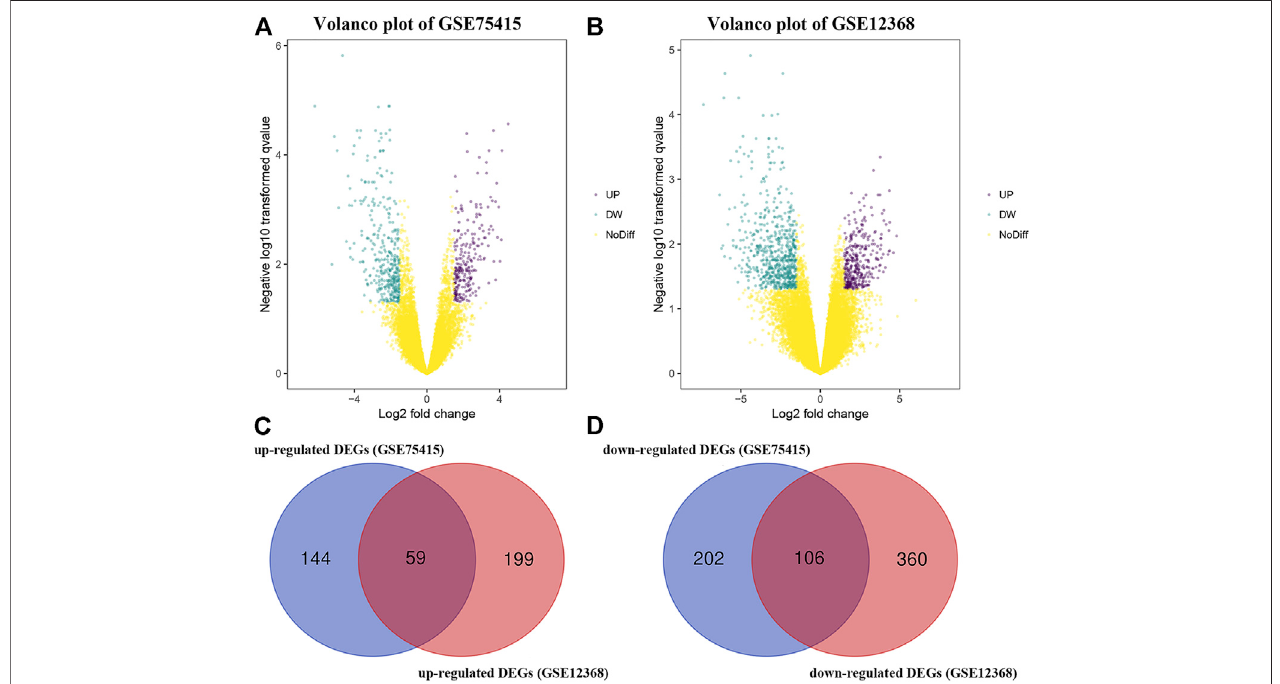
FIGURE 1 | (A) Volcano plot visualizing DEGs in GSE75415. (B) Volcano plot visualizing DEGs in GSE12368. (C) Identi fi cation of overlapped upregulated DEGs between GSE75415 and GSE12368. (D) Identi fi cation of overlapped downregulated DEGs between GSE75415 and